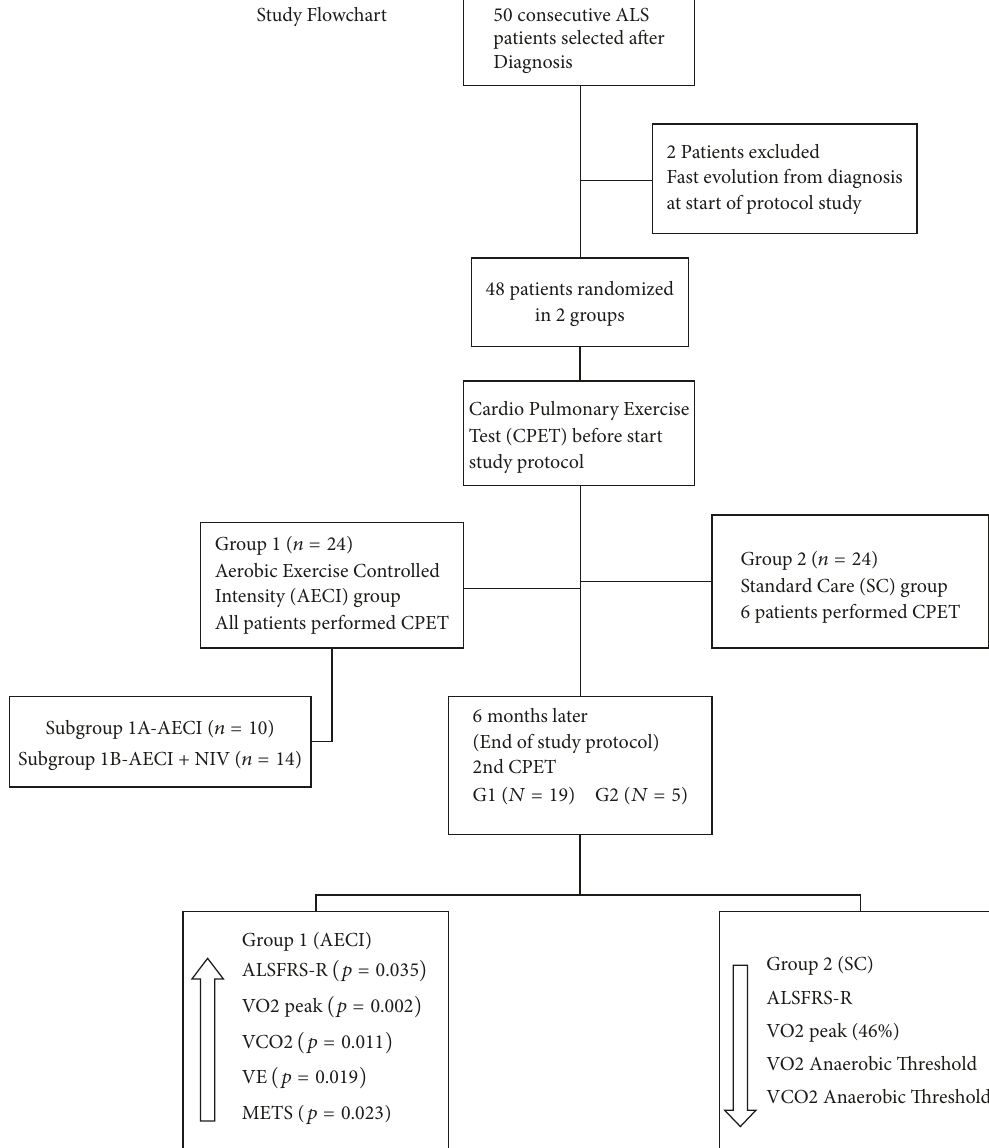
Figure 1: At the end of study we can identify the main findings between groups. The arrows indicate the direction of the significant differences in G1 when compared with standard care group G2. The VO2 peak in G2 reduced 46% since T 1. AECI: aerobic exercise with controlled intensity and NIV: non-invasive